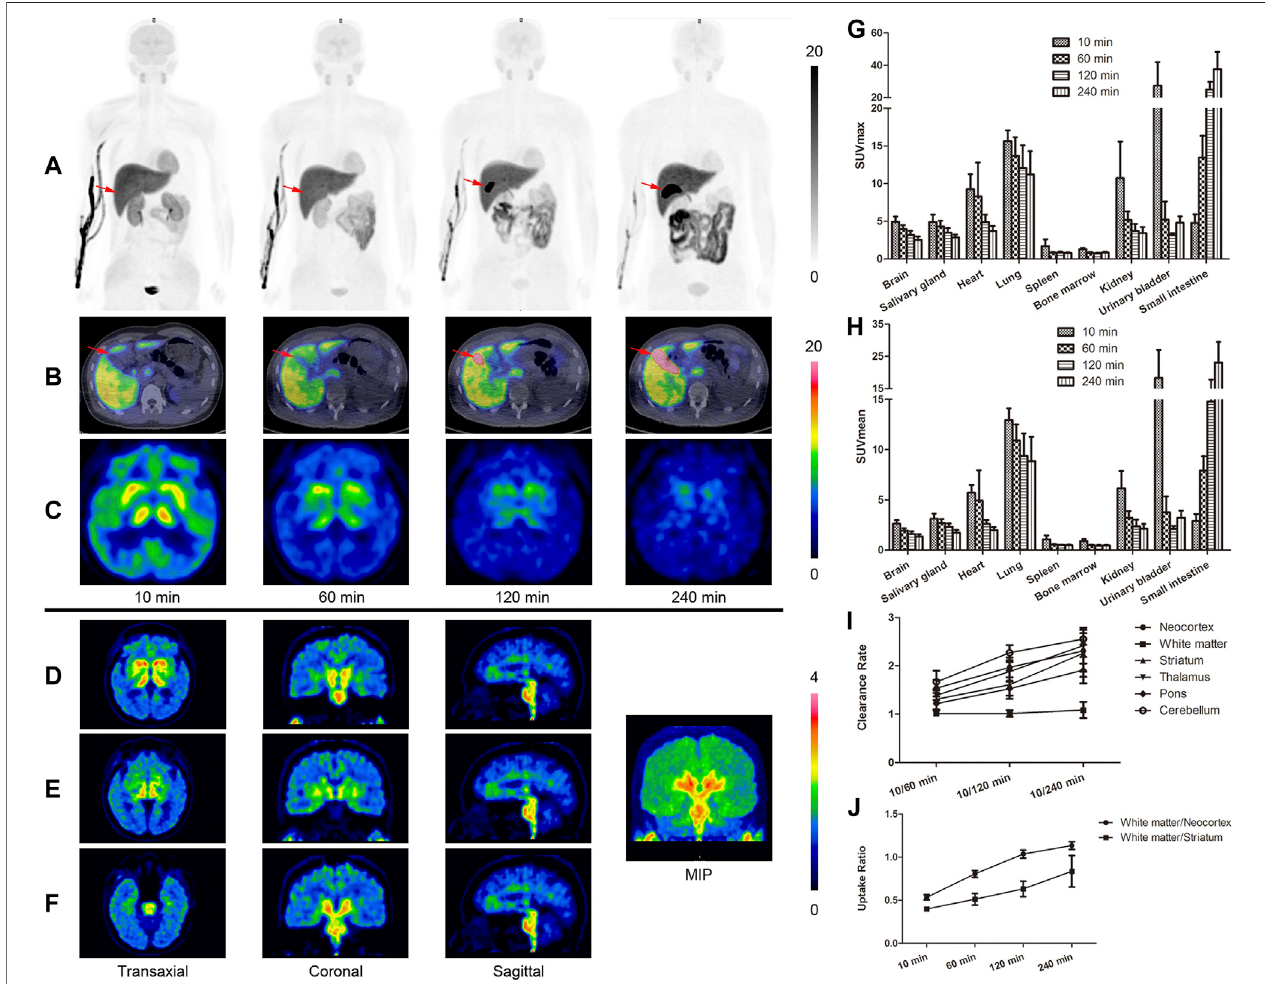
FIGURE 1 | Whole-body positron emission tomography (PET) images of [ 18 F]-S16 obtained in a healthy volunteer acquired over 8-bed positions of varying duration. The maximum intensity projection images of [ 18 F]-S16 at 4 different time points after intravenous injection (A) . The time distribution pattern of [ 18 F]-S16 in the gall bladder ( B , red arrow) and in the brain (C) . The brain PET images obtained after the second whole-body scan, approximately 76 min post-injection, presented a transverse, coronal, and sagittal plane (D – F) . SUV max (G) and SUV mean (H) value of [ 18 F]-S16 in the main organs of healthy volunteers ( n = 4) at 10, 60, 120, and 240 min post-injection. Brain clearance rate (10/60, 10/120, and 10/240 min) (I) and white matter/necortex and white matter/striatum uptake ratio (10, 60, 120, and 240 min) (H) were